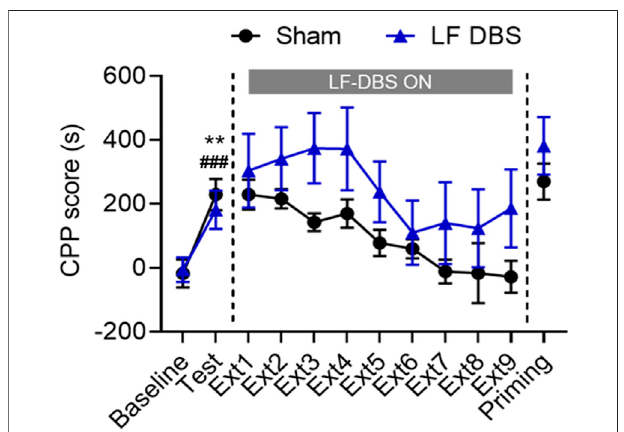
FIGURE3| LFDBSoftheSNrimpaired themethamphetamine-induced CPP extinction and had no effect on methamphetamine-primed reinstatement. After methamphetamine conditioning (1 mg/kg), sham DBS or LF DBS (20 Hz, 150 μ A, 100 μ s) was delivered into the SNr during each ofthedrug-freeextinctionsessions(15 min).LFDBSsigni fi cantlyimpairedthe extinction sessions compared with the sham DBS. A priming injection of methamphetamine (1 mg/kg) was given to the sham DBS and LF DBS groups, and both groups of rats exhibited signi fi cant drug-seeking behaviors. Data are shown as mean ± SEM. ** p < 0.01 (sham DBS) and ### p < 0.0001 compared with baseline (LF DBS). Sham DBS: n (cid:2) 7; LF DBS: n (cid:2)